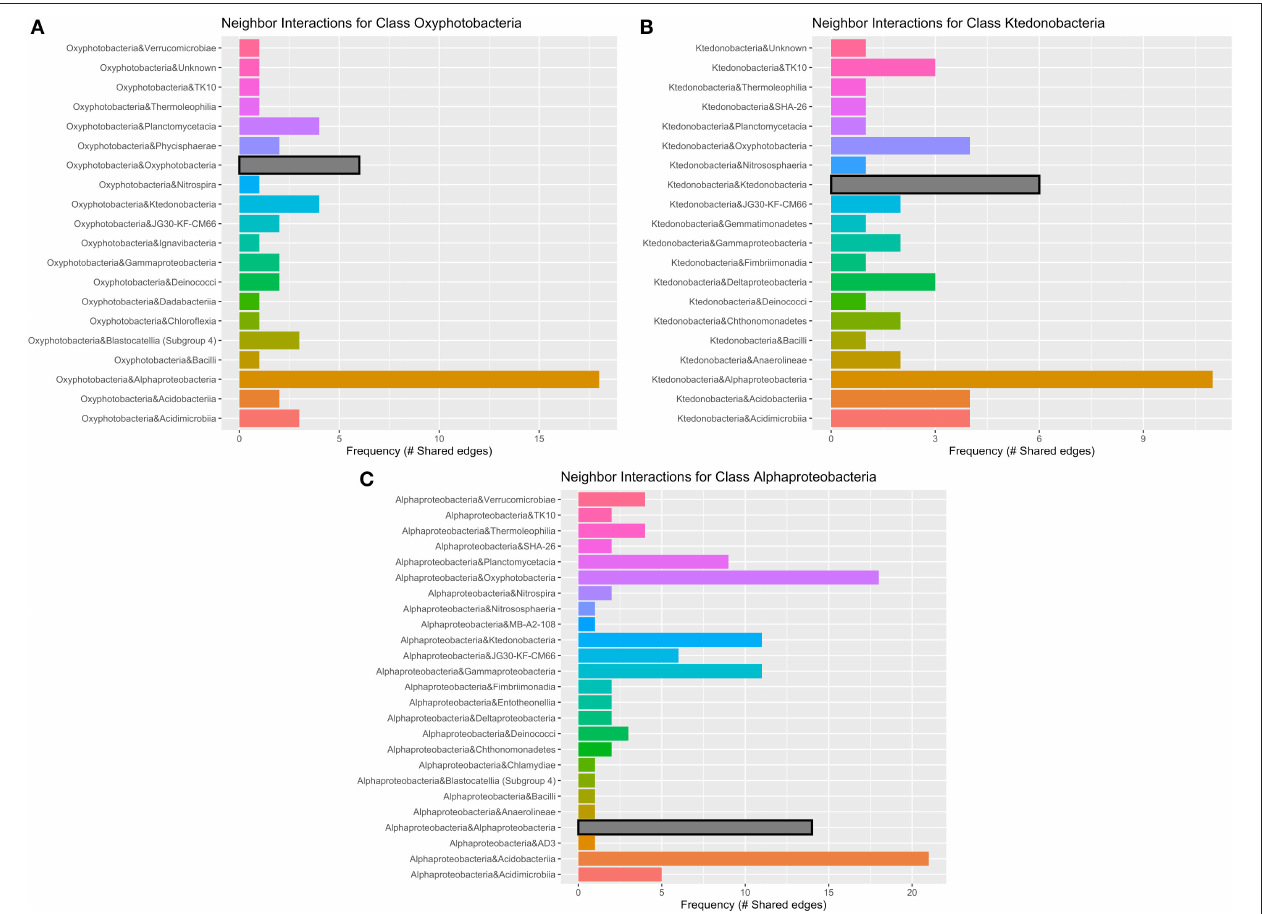
FIGURE 7 | Geothermal neighbor interaction frequency plots at the class level of the three classes with the greatest number of interactions (edges) within the geothermal network: (A) Oxyphotobacteria, (B) Alphaproteobacteria, and (C) Ktedonobacteria. Oxyphotobacteria have the largest number of interactions or co-occurrence with Alphaproteobacteria. However, Alphaproteobacteria have the most interactions with Acidobacteriia, followed by Oxyproteobacteria and then other Alphaproteobacteria. Ktedonobacteria, a common Chloroflexi group in geothermal sites, also has the greatest number of interactions with Alphaproteobacteria, followed by interactions with other Ktedonobacteria.